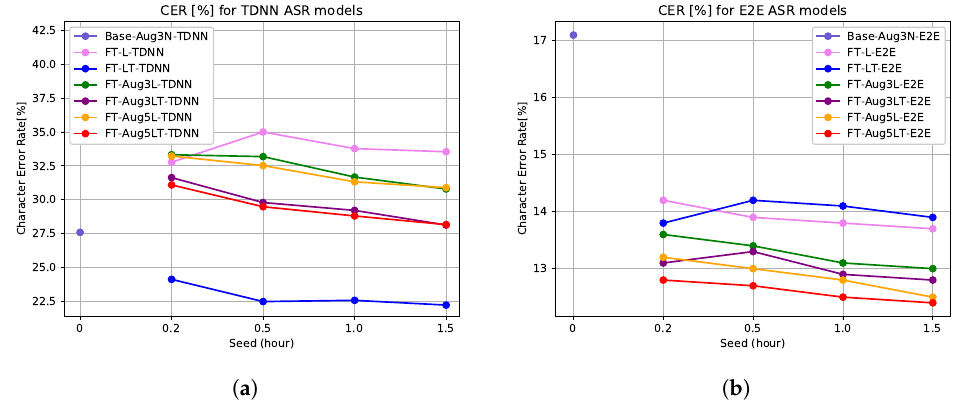
Figure 10. Performance of data augmentation for LTE telephone speech by reducing data size. ( a ) TDNN: domain adaptation for mobile LTE, ( b ) E2E: domain adaptation for mobile